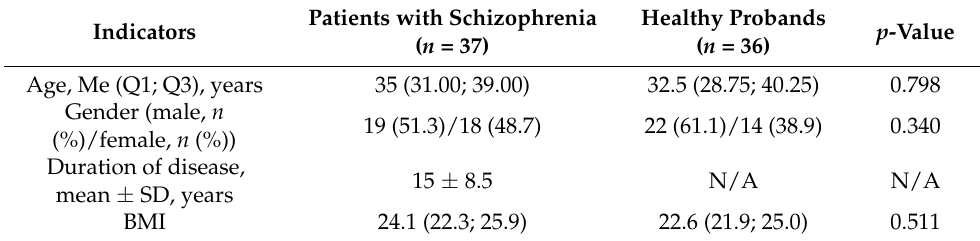
Table 1. The general characteristic of patients with schizophrenia and healthy probands. Indicators